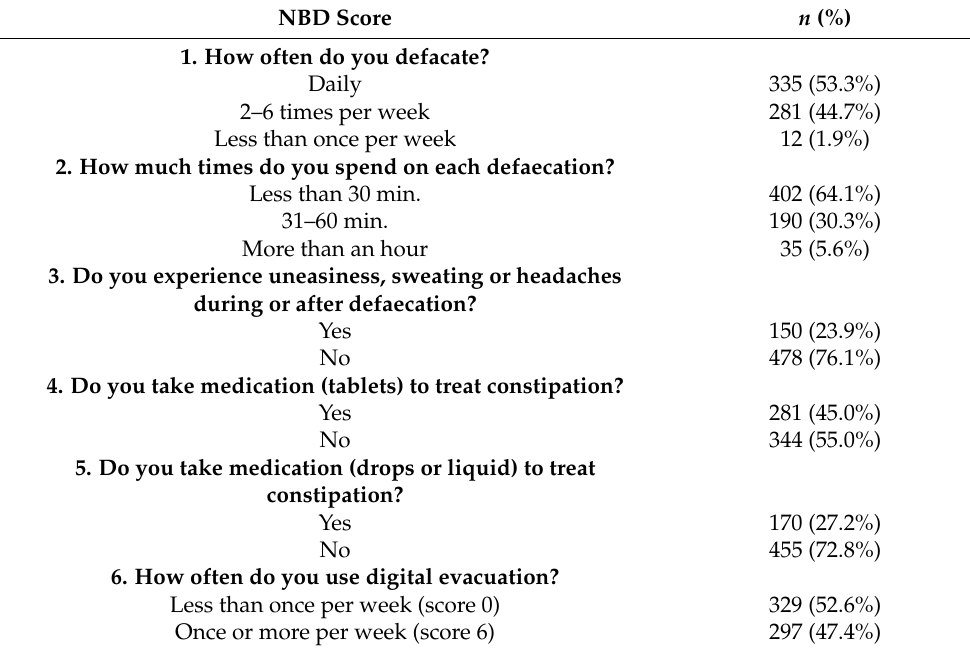
Table 2. The response to the 10 items of the Neurogenic Bowel Dysfunction (NBD). NBD Score n